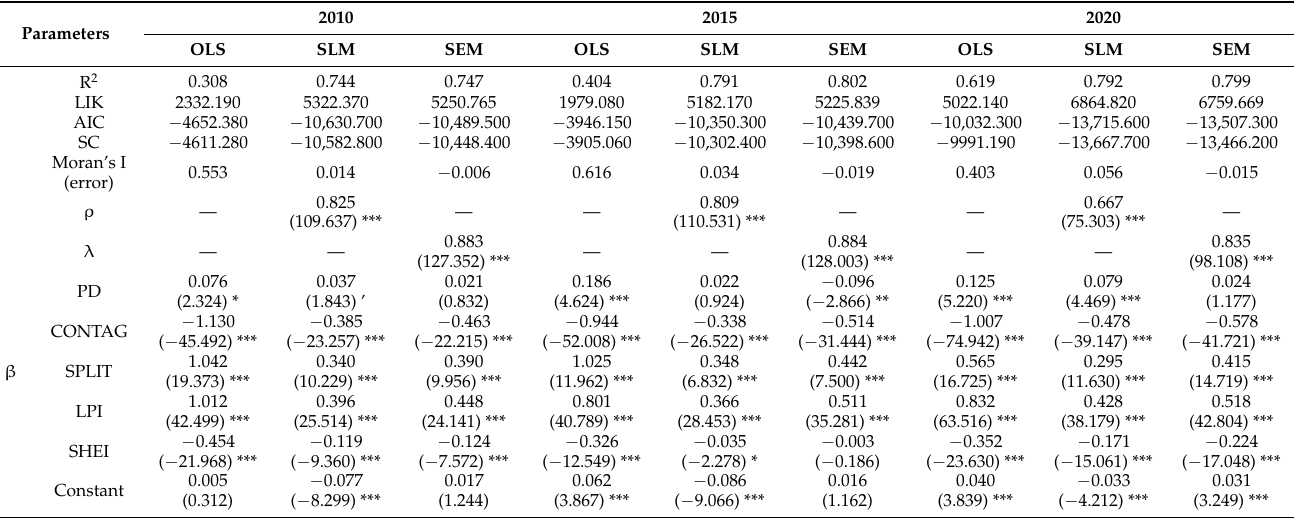
Table 7. Spatial autoregressive model parameters for ESV and the landscape pattern